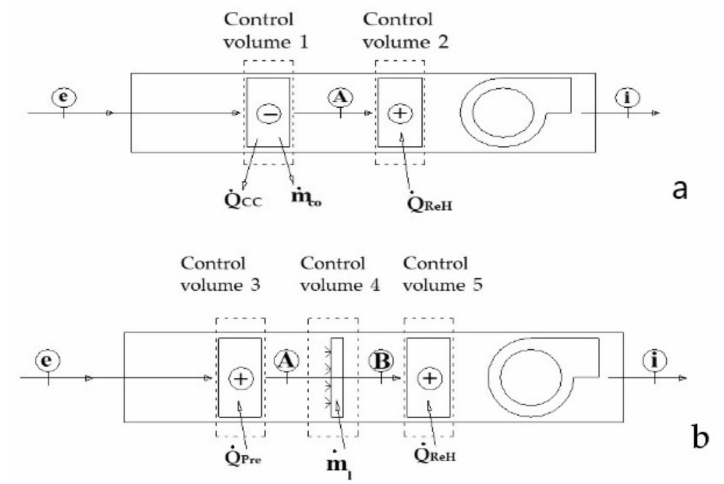
Figure 6. Scheme of the air handling unit for primary air and its components active in ( a ) summer and in ( b )